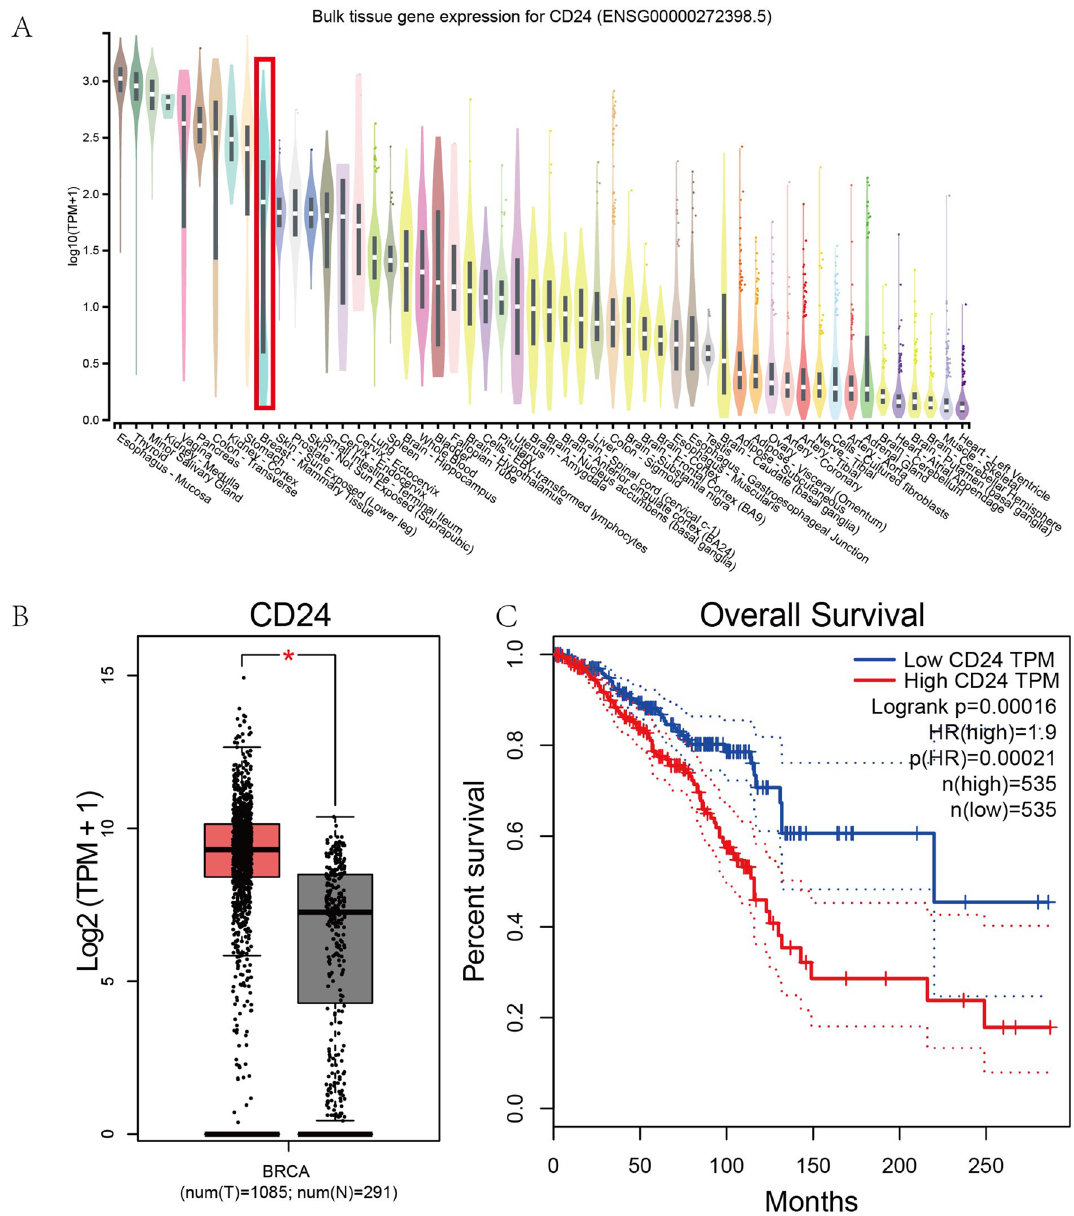
( C ). Survival analysis of CD24 using GEPIA